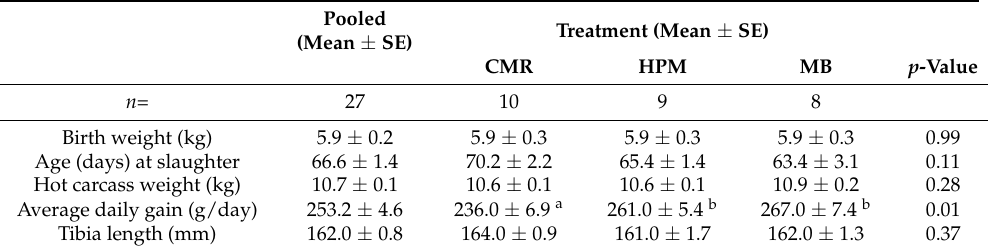
Table 1. Measures of lambs fed milk replacers with variable crude protein to metabolizable energy ratio (mean ± SE, commercial milk replacer (CMR), high protein milk (HPM), milk blend (MB)) and slaughtered at 22 kg live weight. Pooled (Mean ± SE)